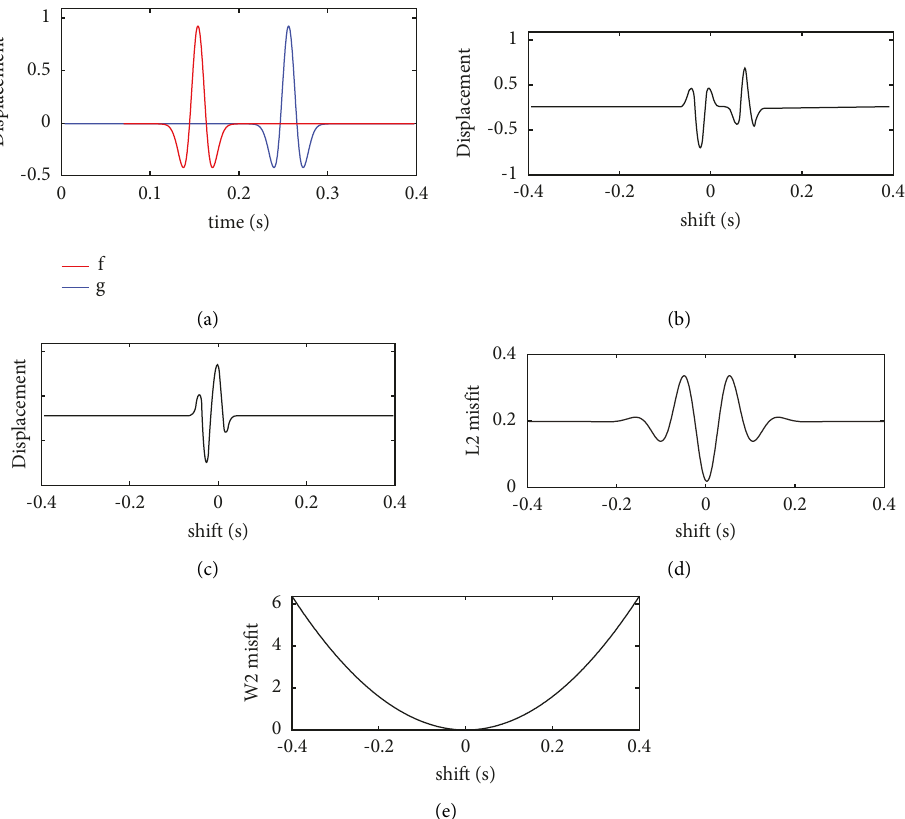
Figure 2: Comparison of the behavior of adjoint source and objective function for L2-norm and W2-norm. (a) Synthetic waveform: g and observed waveform: f, (b) the adjoint source of L2-norm, (c) the adjoint source of W2-norm, (d) L2-norm misfit, and (e) W2-norm misfit.